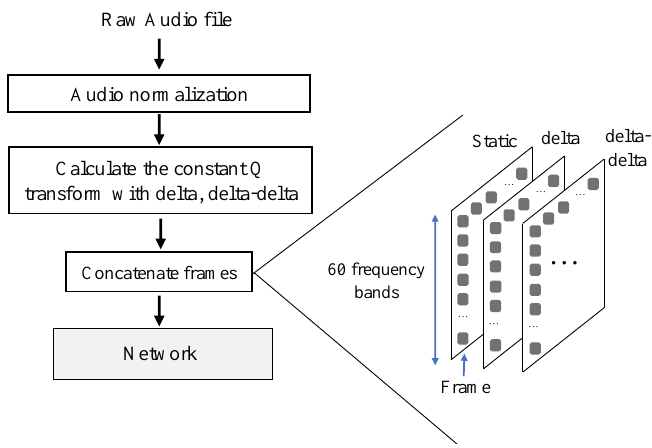
Figure 4. Block diagram showing the audio pre-processing steps. First, the audio is normalized using basic audio normalization, and the constant Q transform (CQT) feature along with the delta and delta-delta features are subsequently